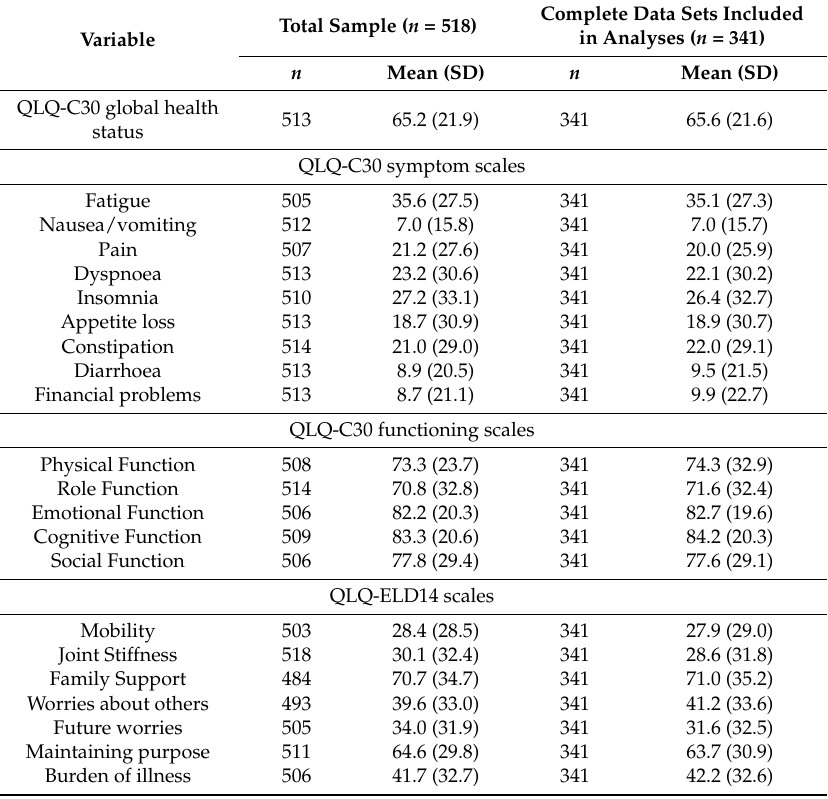
Table 3. EORTC QLQC30 and QLQ-ELD14 scales ( n = 518; n = 341 complete data sets included in regression